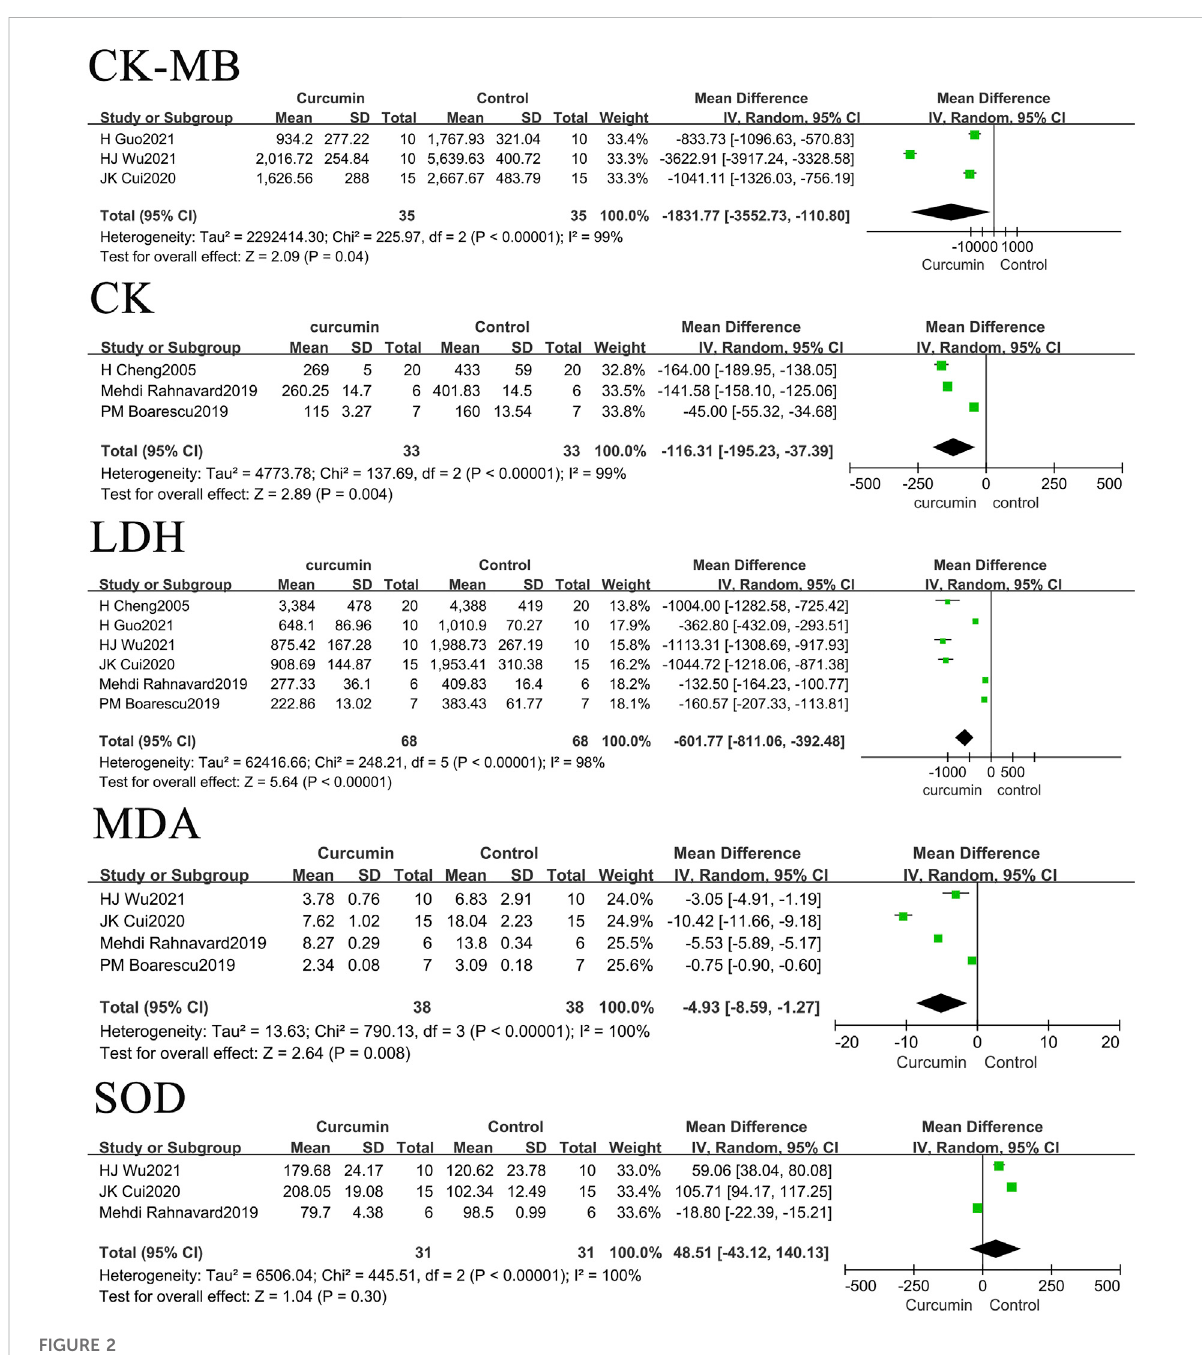
Forest plot of blood biochemical related indicators: CK-MB, CK, LDH, MDA,